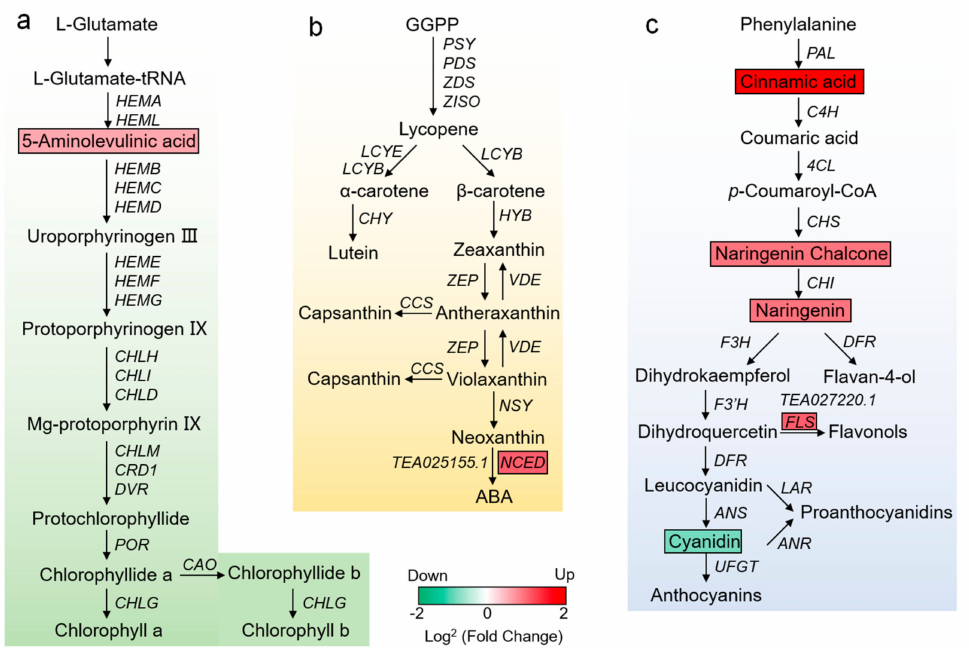
Figure 6. DEGs and SCMs involved in pigment metabolism pathways. ( a ) Chlorophyll biosynthesis pathway. ( b ) Carotenoid biosynthesis pathway. ( c ) Flavonoid biosynthesis pathway. Rectangles marked with green and red backgrounds represent reduced and increased levels of DEGs and SCMs,